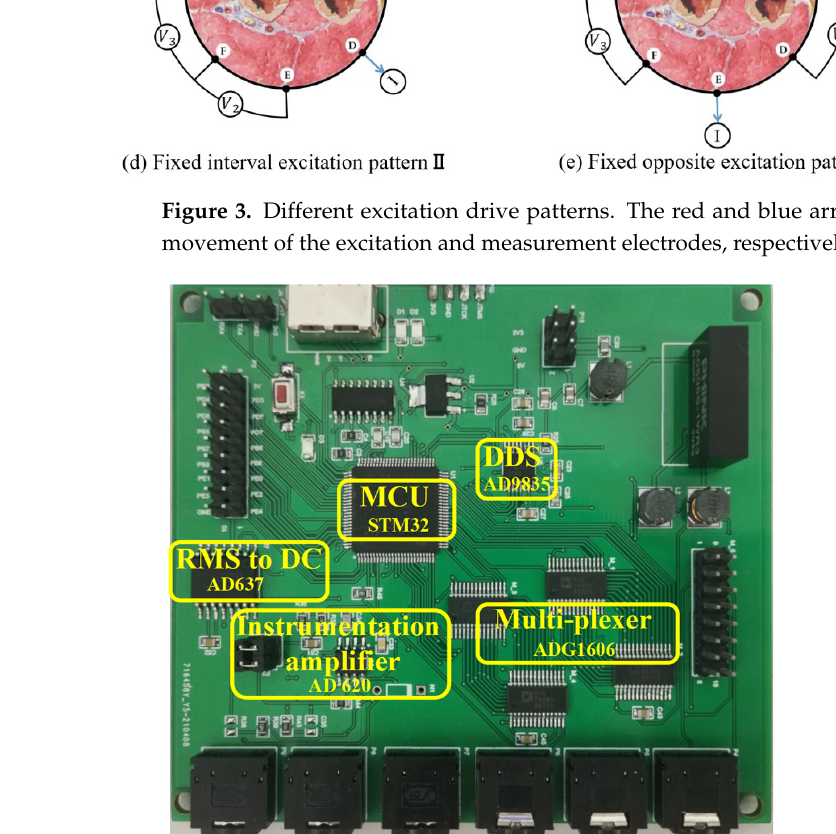
Figure 5. Overall architecture diagram of system hardware. The red line in the figure represents the input terminal of the excitation current, and the blue line represents the measurement terminal of the induced voltage. For each dynamic gesture, 40 measured values can be obtained through measure- ment. The details of data acquisition for each measurement pattern are shown in Table 1. The contact between the electrode and the skin will introduce contact impedance, which brings inevitable errors to the collection of gesture data. This experiment uses a silver chloride medical ECG electrode with a conductive gel to reduce the contact impedance between the skin and the electrode in order to obtain stable and accurate measurement results. Table 1. Data collection details for different measurement methods. Excitation Pattern Excitation Electrode Pair